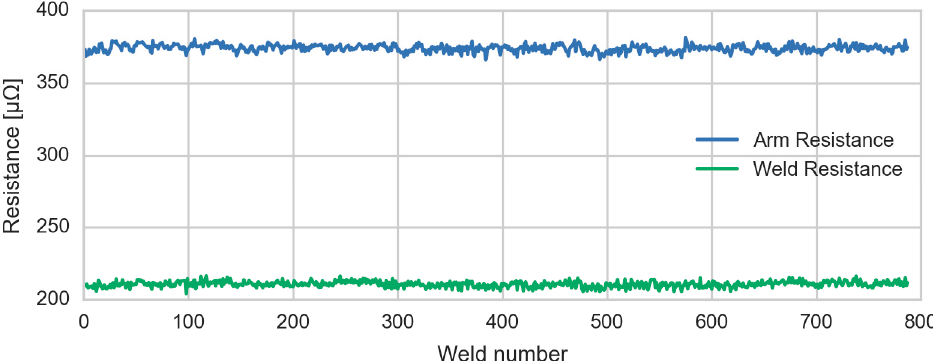
Figure 6. Virtual Sensor Resistance Output Values.